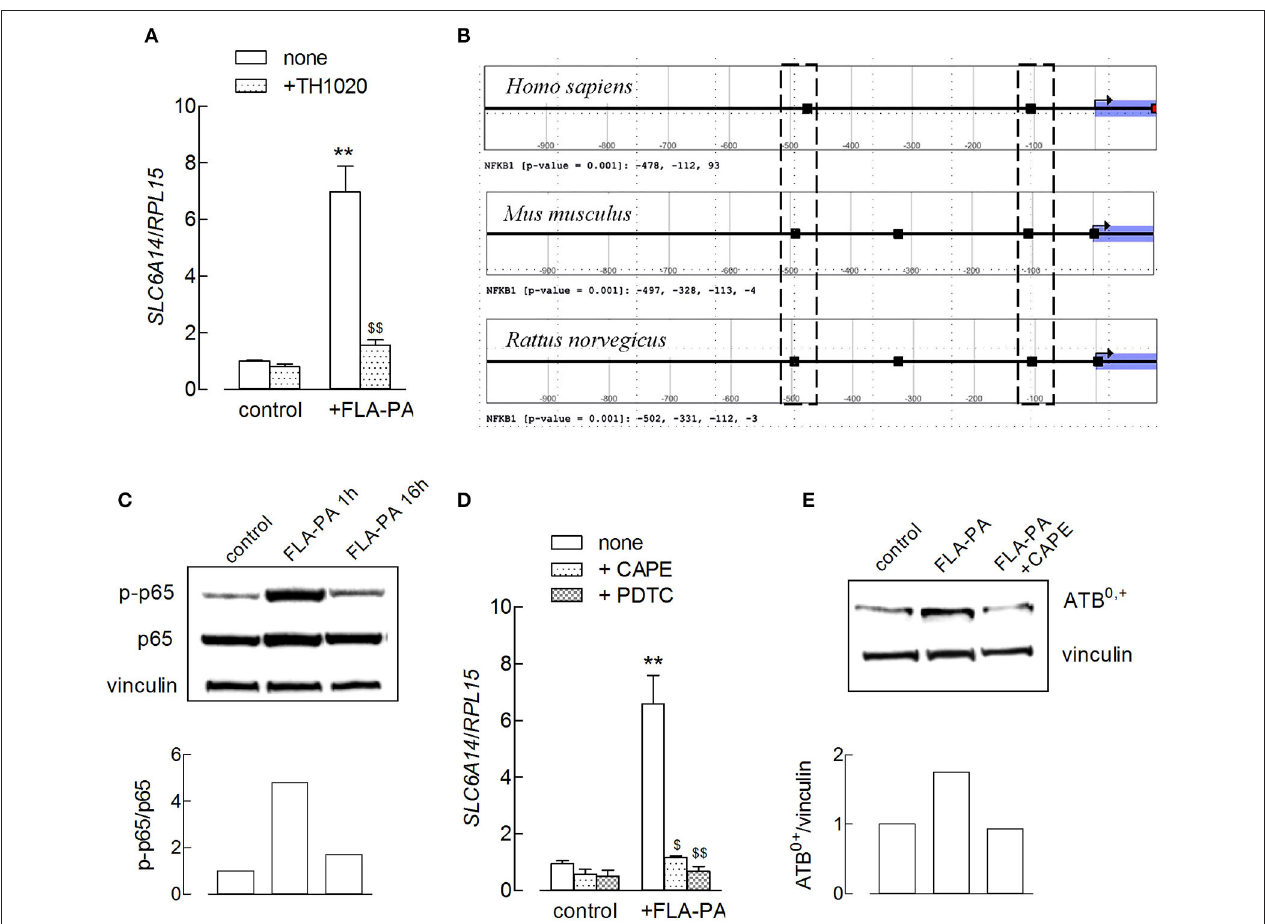
FIGURE 3 | (A) Calu-3 cells were pretreated for 1h with TH1020 (20 µ M), before the incubation with 2 µ g/ml FLA-PA for 6h. The expression of SLC6A14 /ATB 0, + was then determined by means of RT-qPCR, as described in the section “Materials and methods”. Data of three experiments, each performed in duplicate, are